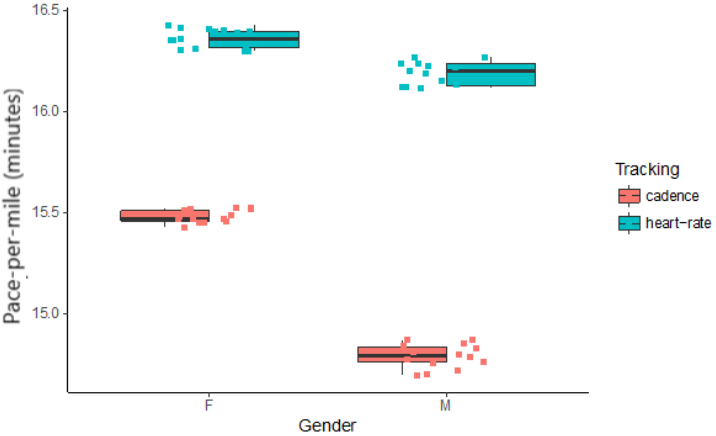
Table 1. Type III 2-way unbalanced design ANOVA for Pace per Mile.